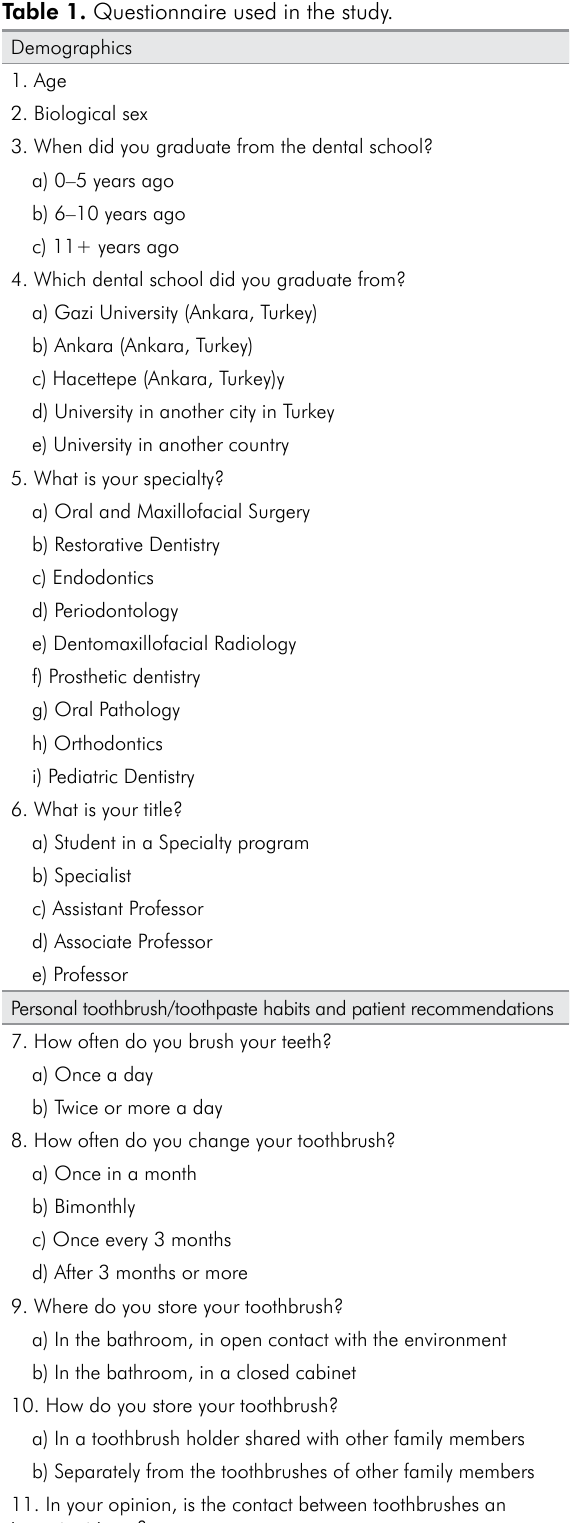
Table 1. Questionnaire used in the